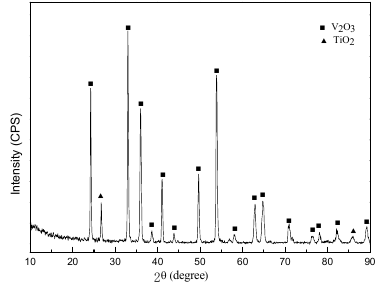
Figure 1. XRD patterns of the oxide mixture after sintering at 1373 K for 2 h.